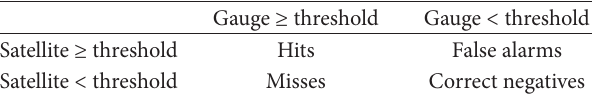
Table 1: Contingency table for comparing gauge-based analysis and satellite estimates. The threshold used for rain/no-rain discrimina- tion is 1.0